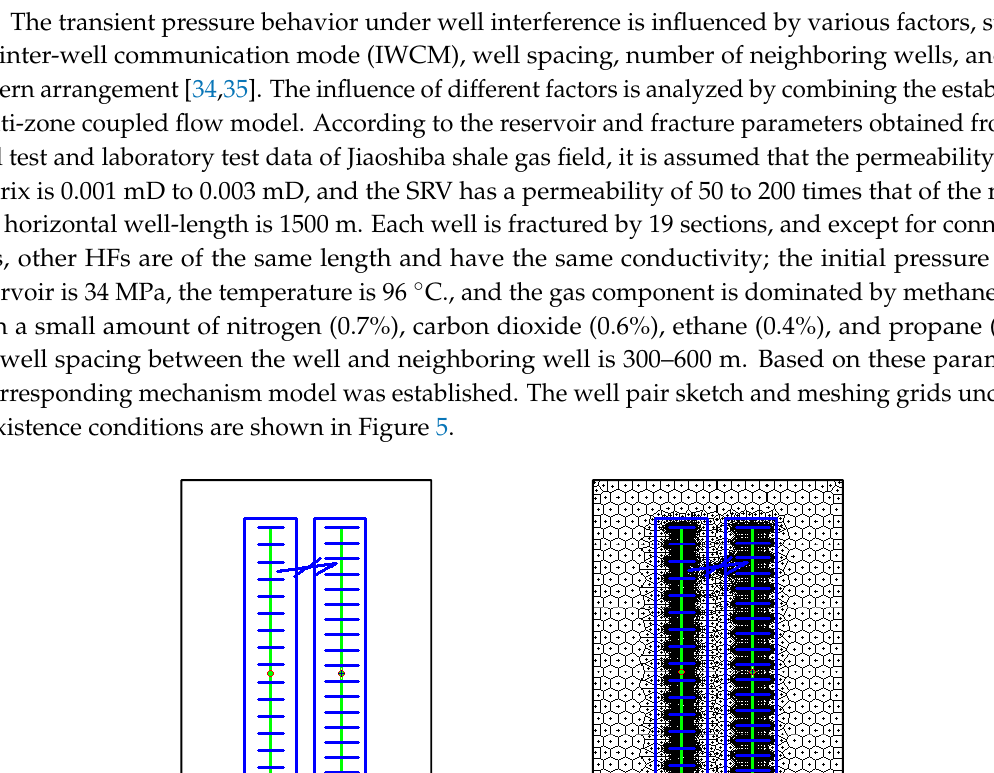
Figure 4. A1-1 bottomhole pressure (BHP) fitting results (A1-3 was a new neighboring well produced at June 2017).